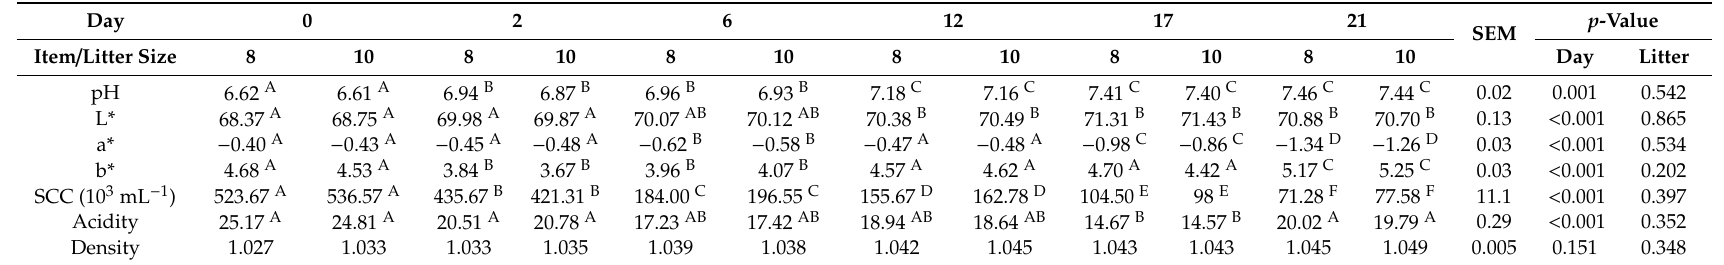
Table 1. The e ff ect of litter size and lactation day on the physical traits of rabbit milk.